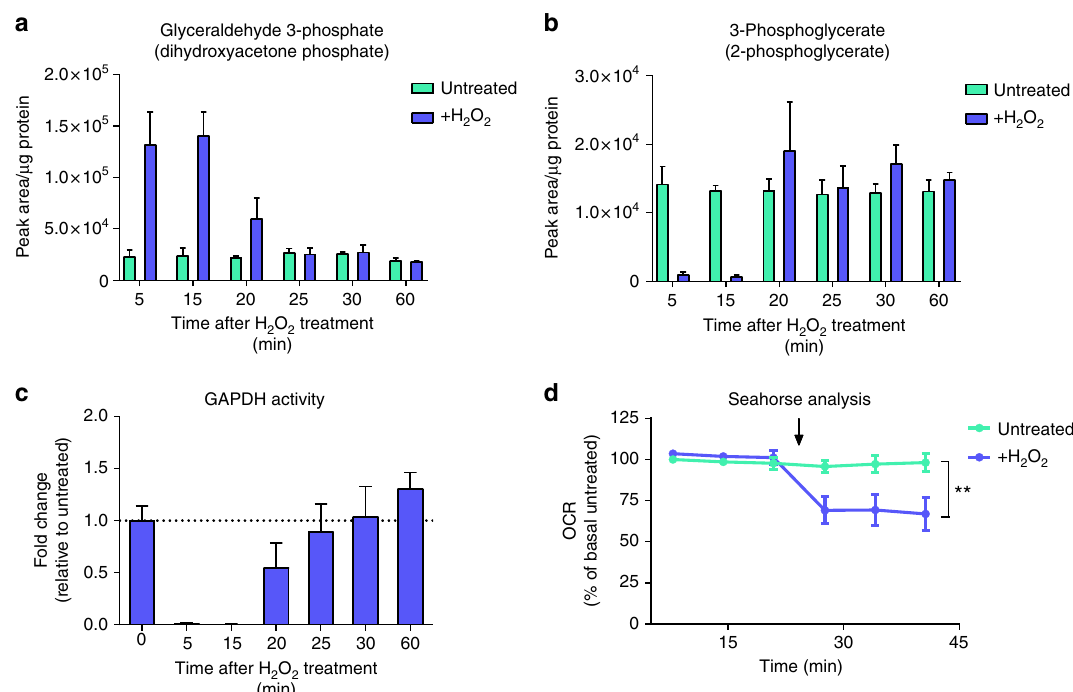
Fig. 6 Oxidative inhibition of GAPDH is transient and acute oxidative stress reduces mitochondrial respiration. Metabolite abundance of GAPDH substrate ( a ), downstream metabolite ( b ), and resultant relative GAPDH enzymatic activity ( c ) after treatment with 500 µ M hydrogen peroxide for 15 min and subsequent cellular recovery. d Relative oxygen consumption rate (OCR) in response to treatment with 350 µ M hydrogen peroxide. Arrow indicates addition of hydrogen peroxide. a – c Mean (S.D.) of three independent experiments with triplicate measurements; d mean (S.D.) of three independent experiments with 12 replicate measurements per treatment. ** p value = 0.0052 (two-way ANOVA with Dunnet ’ s test for multiple comparisons